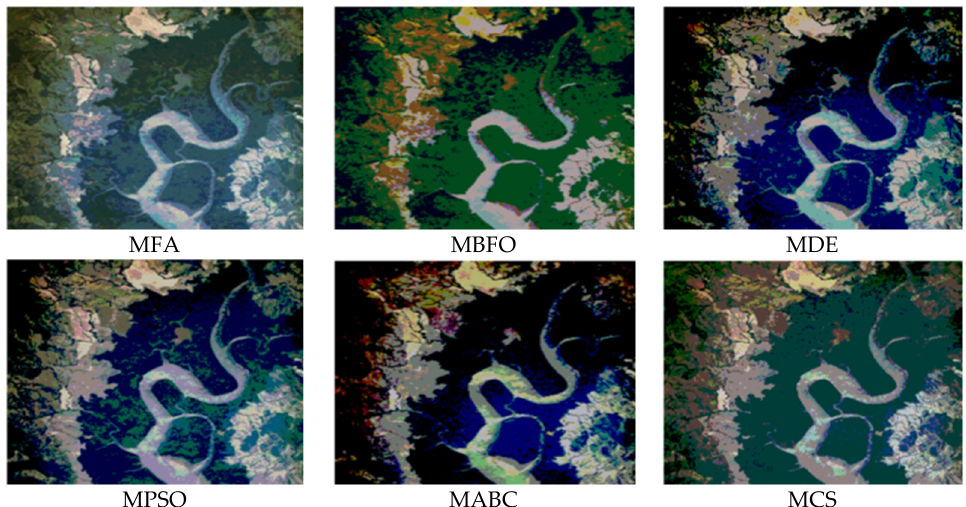
Figure 17. Rényi’s entropy function-based segmented images using MFA, MBFO, MDE, MPSO, Figure 17. R é nyi’s entropy function-based segmented images using MFA, MBFO, MDE, MPSO, MABC, and MCS for thresholding level 12. MABC, and MCS for thresholding level